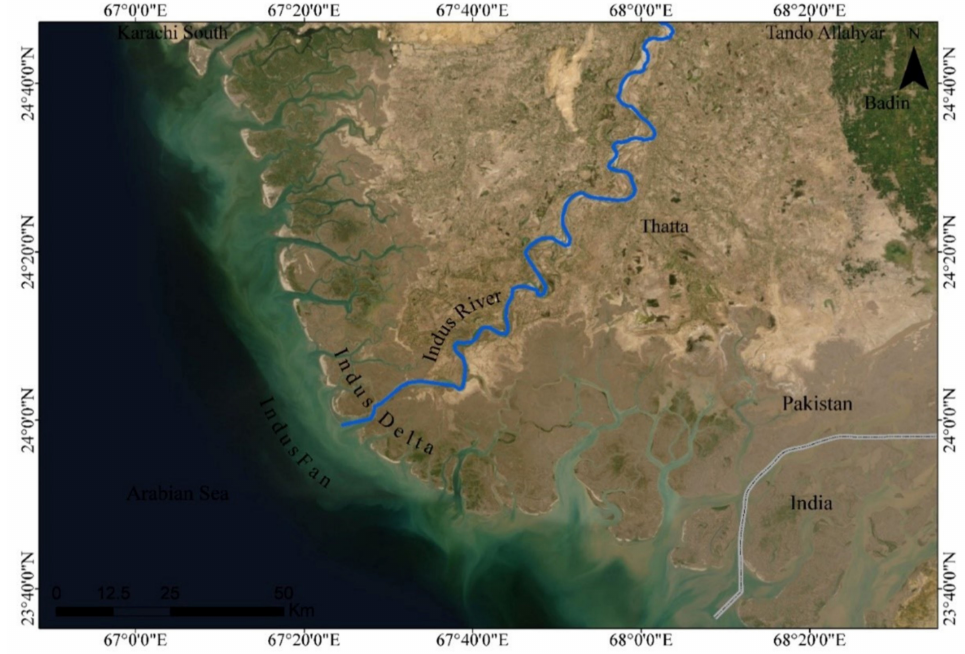
Figure 5. Location of several rivers and particularly the Indus River delta in